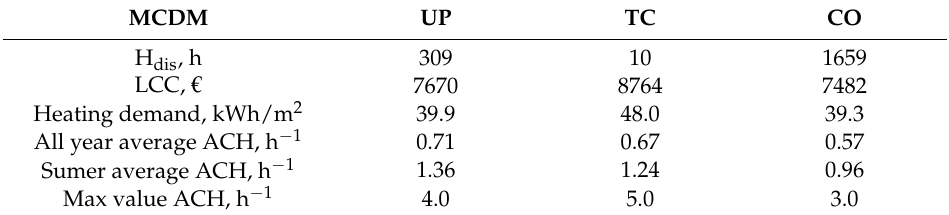
Table 7. Optimal results for case